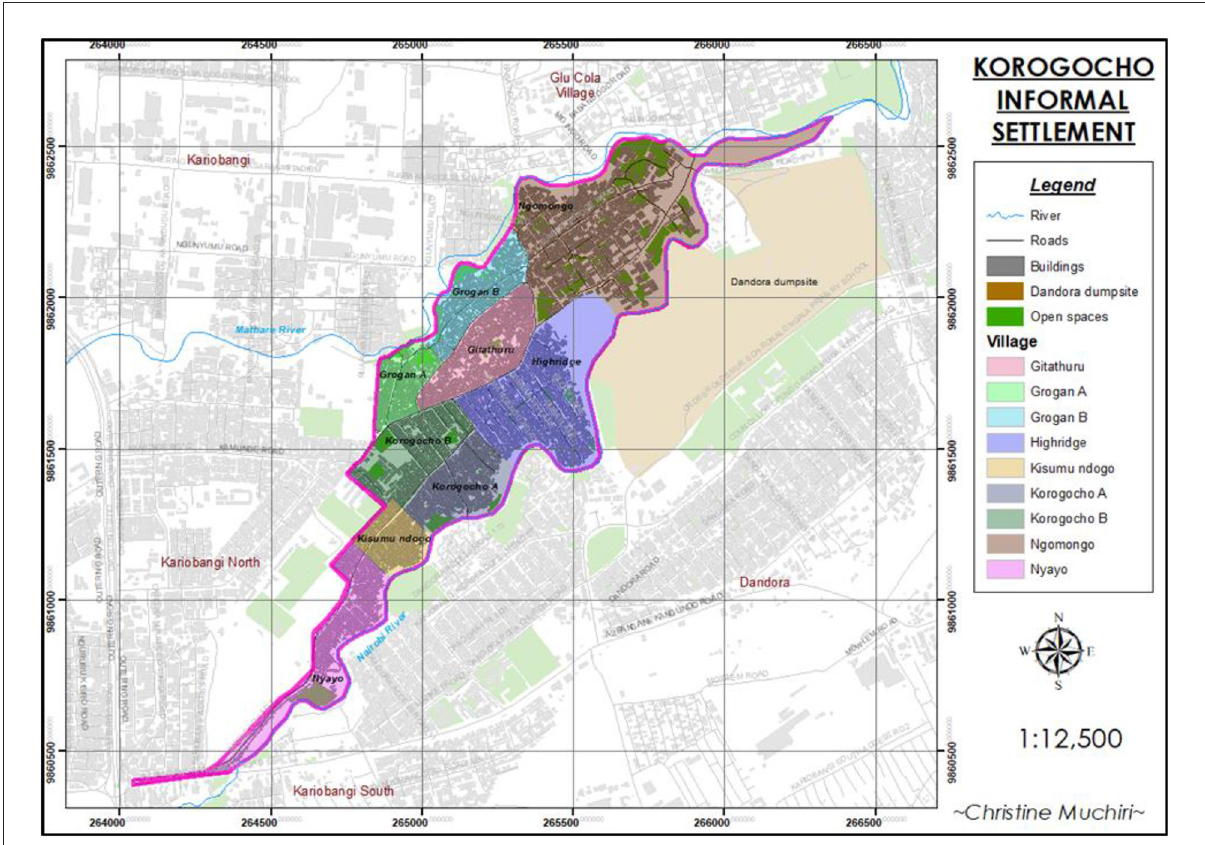
FIGURE1 Korogocho informal settlement. Source: Muchiri and Opiyo